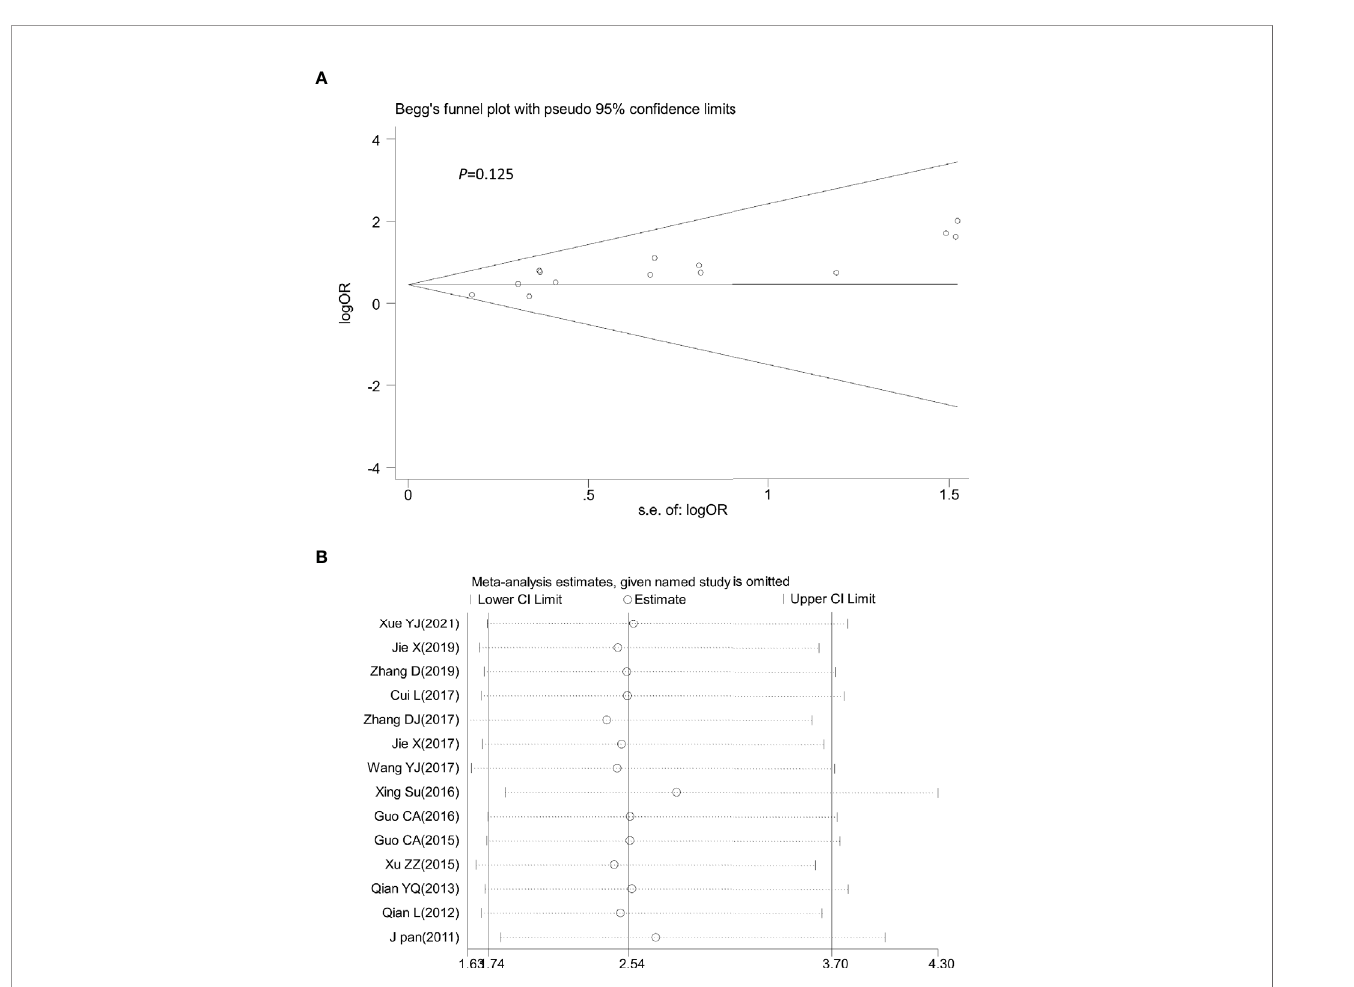
FIGURE 9 | Begg ’ s funnel plot (A) and sensitivity analysis (B) of all the included studies for the analysis of CR. Begg ’ s test ( p = 0.125). CR, complete